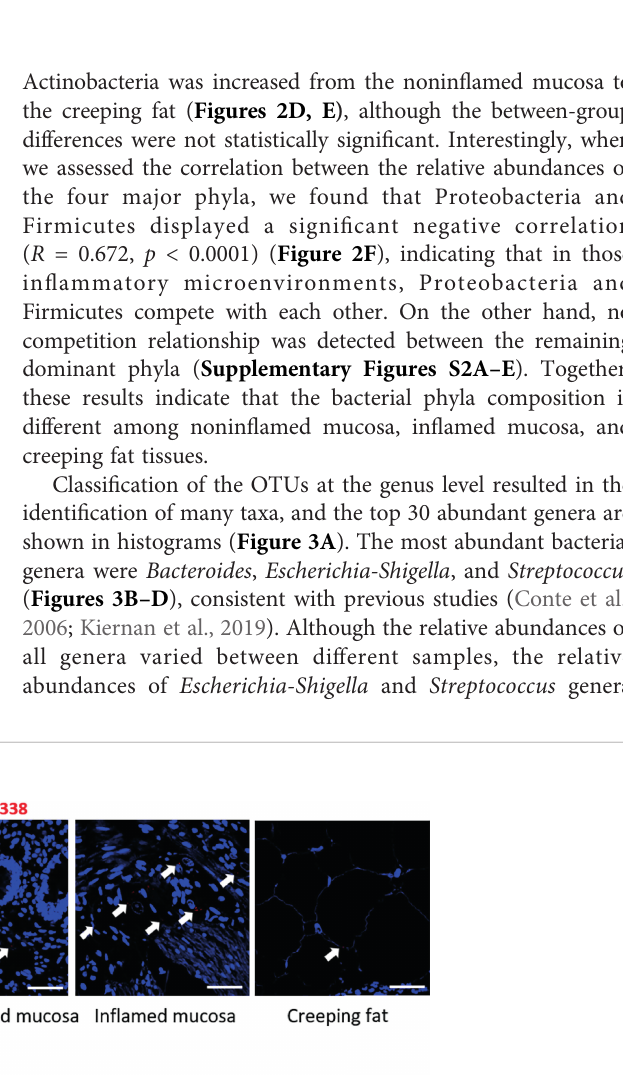
M, male; F, female; B2, stricturing; B3, penetrating; 5-ASA, masalazine; AZA, azathioprine; MP, methylprednisolone; IFX, in fl iximab. All patients received antibiotics at induction of